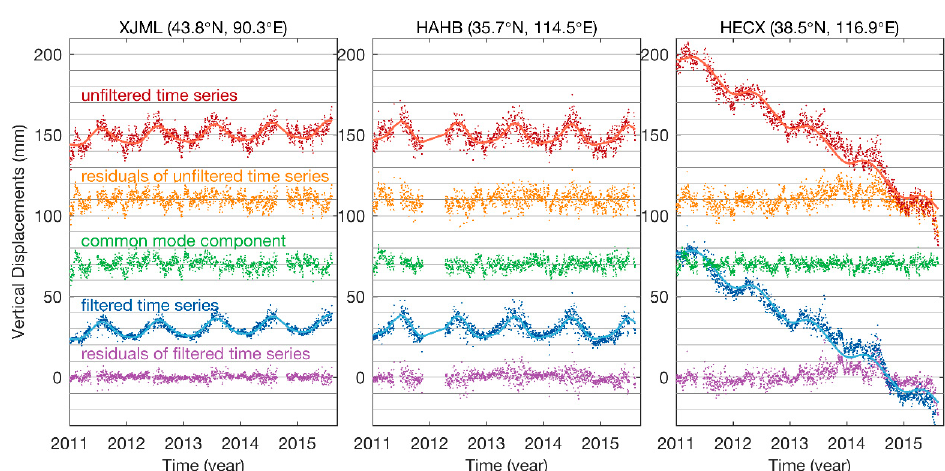
Figure A5. Unfiltered time series (red, shifted upward by 150 mm) and their residual time series (orange, shifted upward by 110 mm) obtained with Equation (1), common mode error (green, shifted upward by 70 mm), and filtered time series (blue, shifted upward by 30 mm), and their residual time series (purple) obtained with Equation (1) for the selected three vertical position time series of the CMONOC-II stations, in which station XJML, HAHB and HECX are characterized by the maximum, medium and minimum RMS reduction in CMONOC-II after the filtering, respectively.